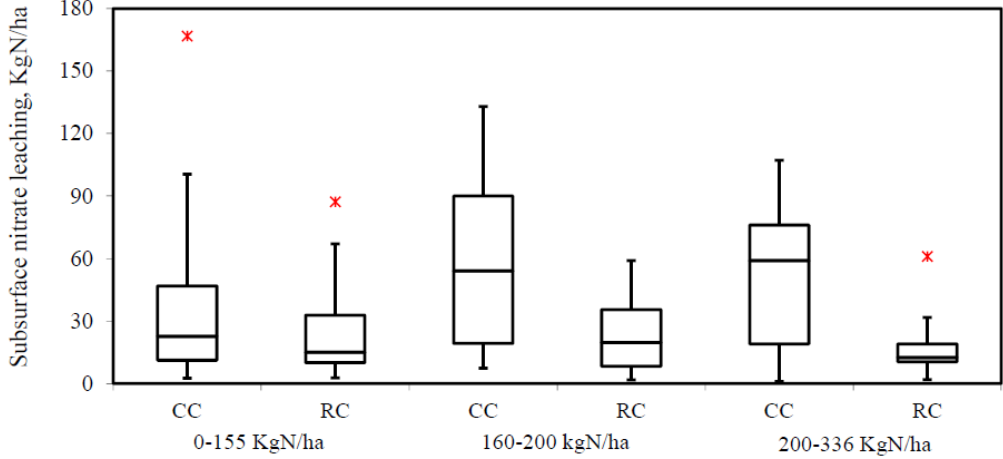
Figure 10. Nitrate leaching from fine loamy soil in continuous corn (CC) and corn in rotation (RC) (fifteen and twelve journal articles were used for analysis).